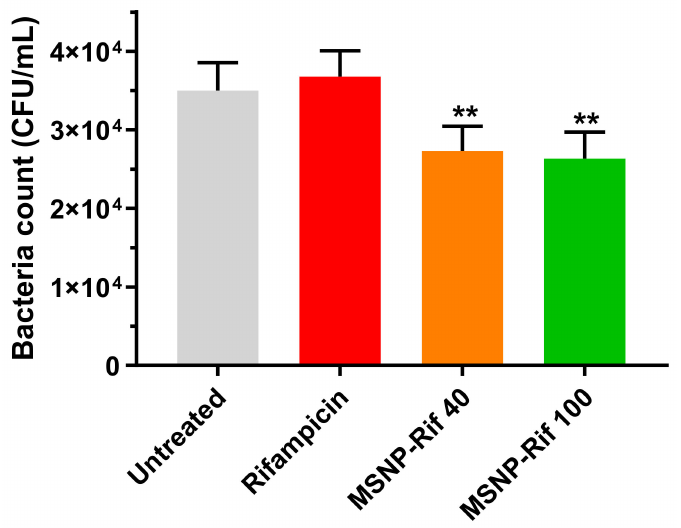
Figure 7. E ffi cacy of rifampicin and MSNP-Rif against SCV S . aureus (mean ± SD, n = 3). (Note: ** indicates MSNP-40 and MSNP-100 significantly di ff erent to untreated and unformulated rifampicin, p <